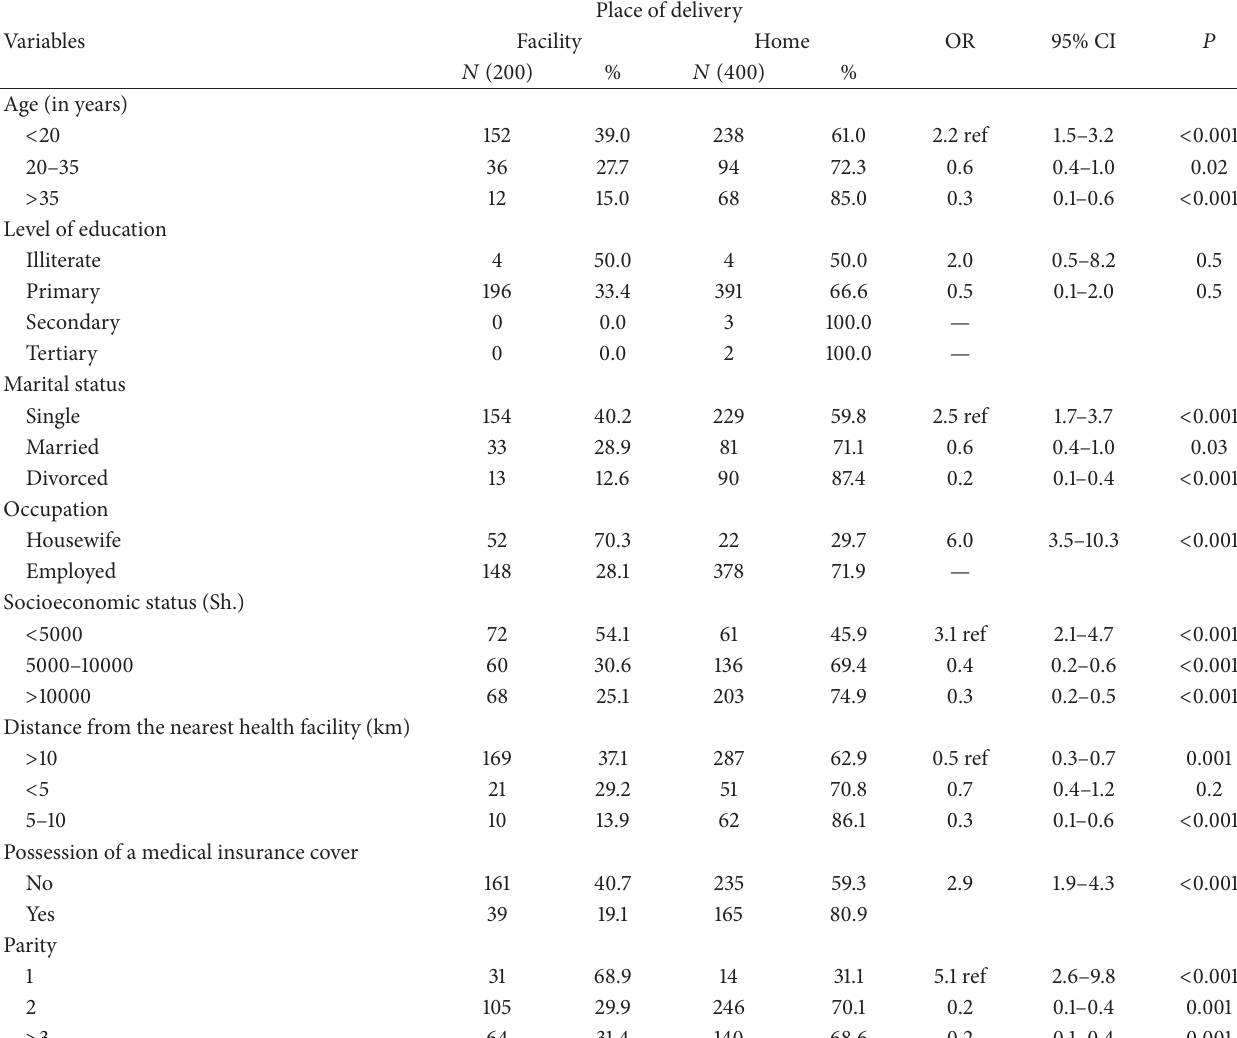
Table 1: Sociodemographic correlates for choice of place of childbirth. Place of